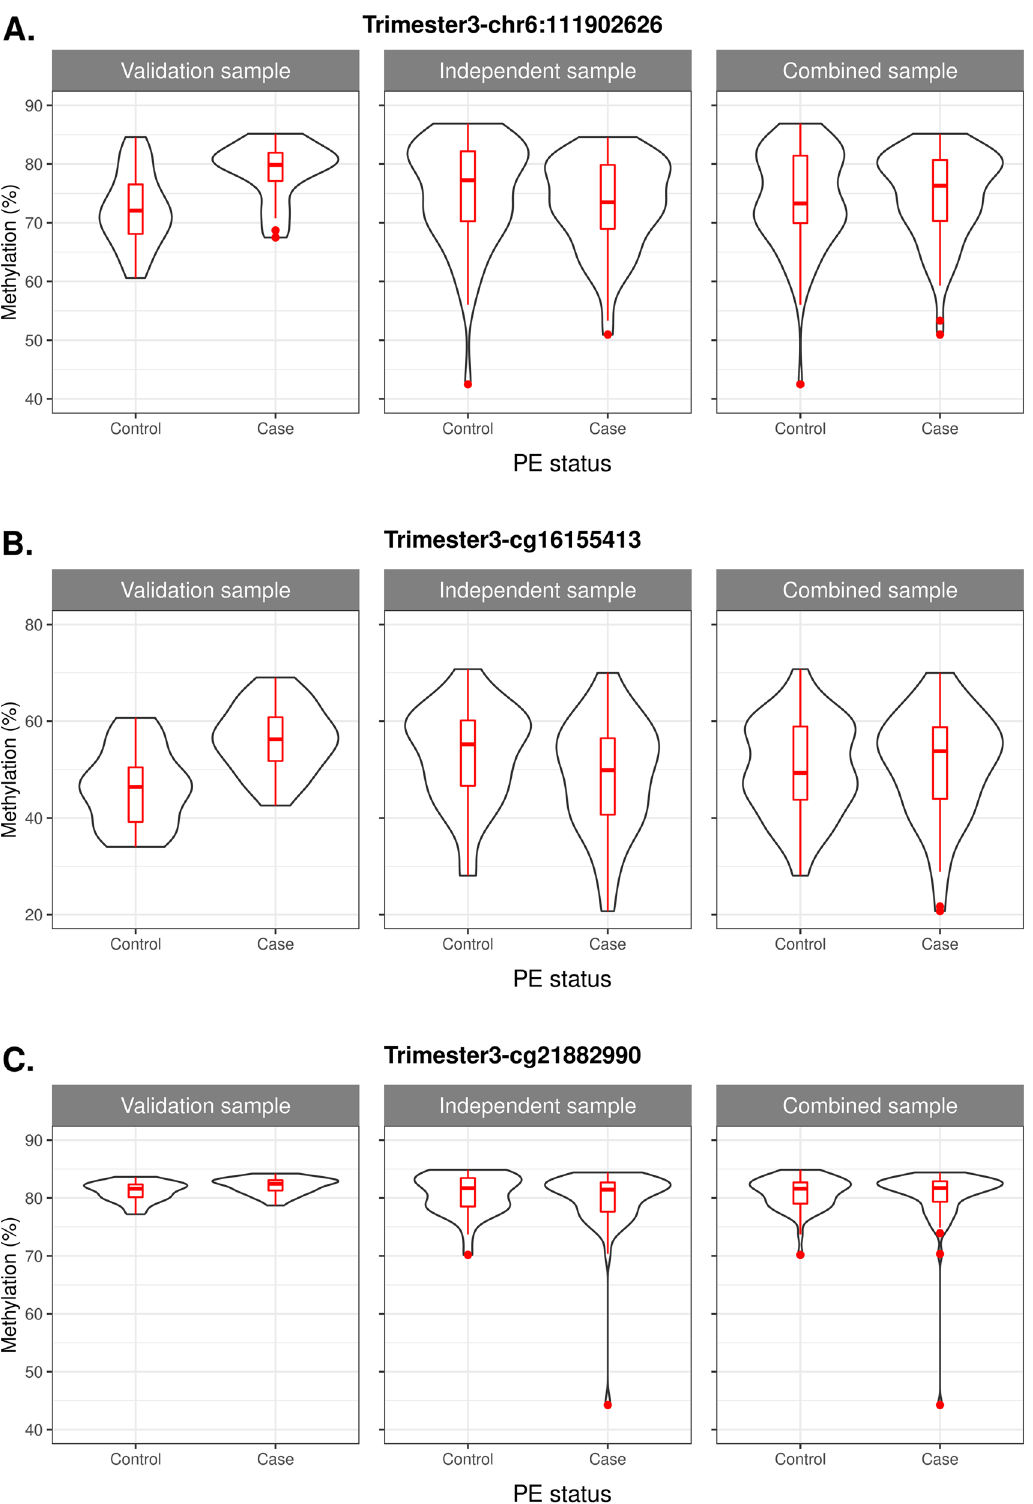
Fig. 4 Trimester 3 replication phase: Distribution of DNA methylation levels (as beta values). Validation sample, those with DNAm data from both the discovery (Infinium ® MethylationEPIC Beadchip) and replication (pyrosequencing platforms); independent sample, an independent sample of participants completely separate from the discovery phase; combined sample, a combination of validation and independent